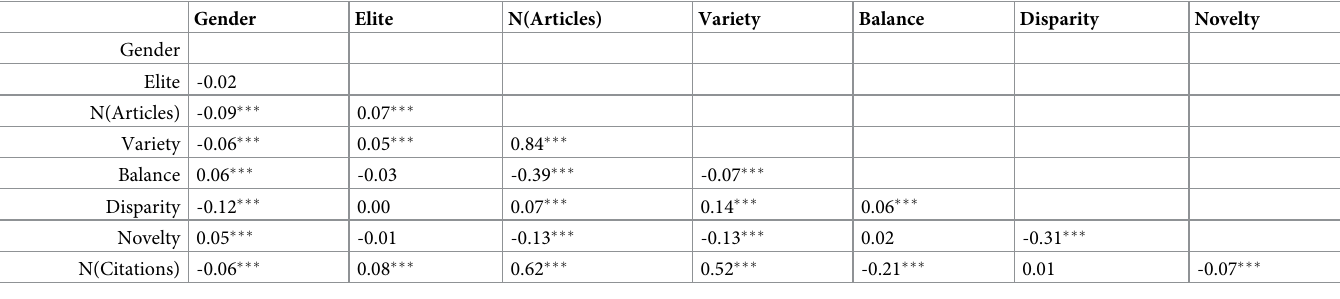
Table 2. Psychology